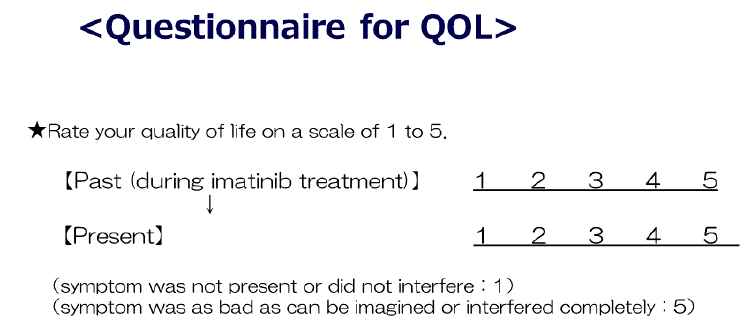
Figure 2. An interview form for quality of life (QoL) was prepared for all patients. QoL was judged on a scale 1 to 5 during imatinib (IM) treatment (in the past) and during nilotinib (NILO) treatment (in the present).